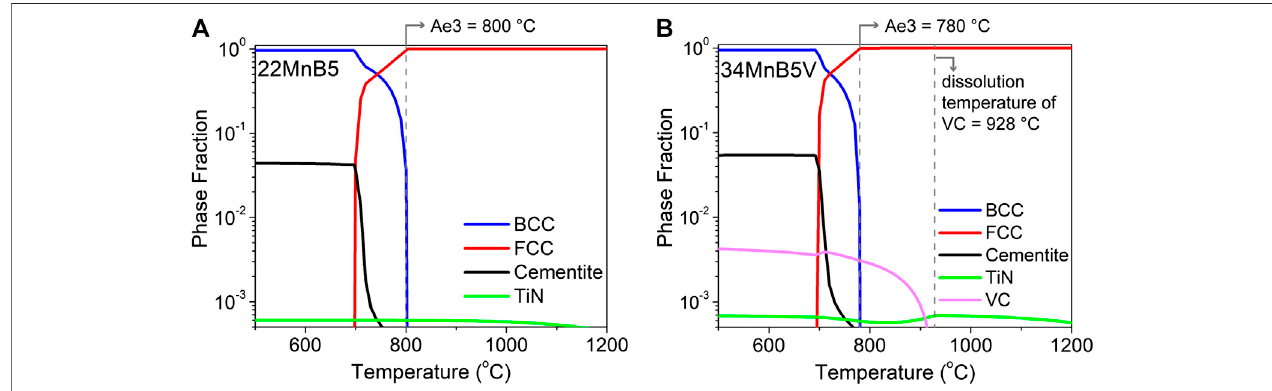
FIGURE 2 | The schematic diagram showing the thermal cycle in the simulated press hardening.